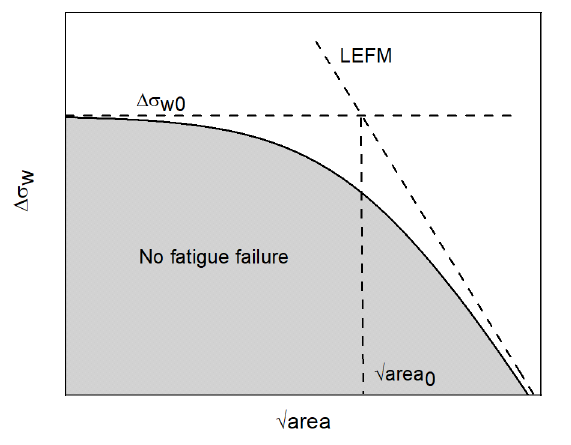
Figure 10. Schematic representation of the Kitagawa